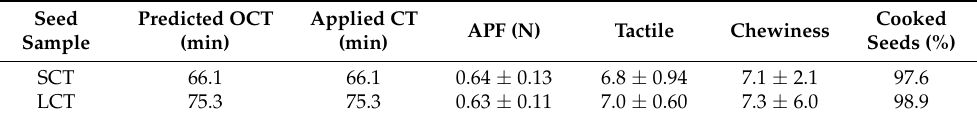
Table 5. Weighted average of APF (absolute positive force) tactile texture and chewiness ± standard deviation, as well as percentage of cooked seeds of easy-to-cook SCT and hard-to-cook LCT seed samples during cooking at 100 ◦ C at previously predicted optimal cooking time